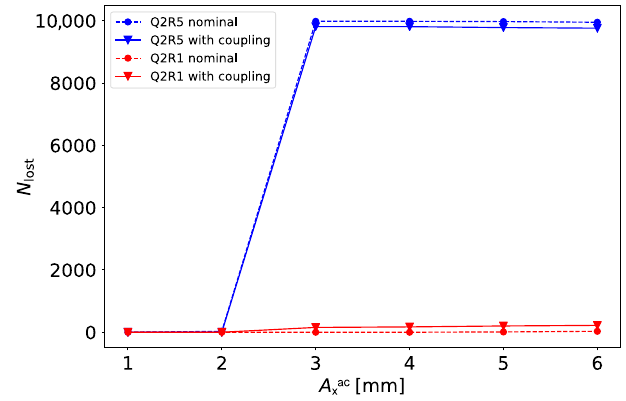
FIG. 8. Particles lost at Q2R5 and Q2R1 magnets as a function of the horizontal ac-dipole kick amplitude for an ideal optics with zero coupling and with the moderate coupling scenario described in this